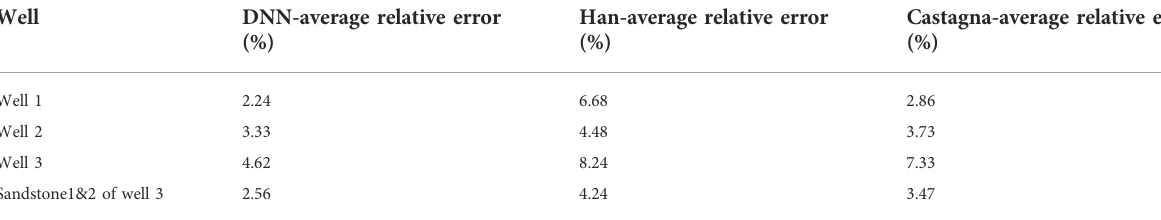
TABLE 4 Average relative error of the three S-wave velocity prediction methods in different